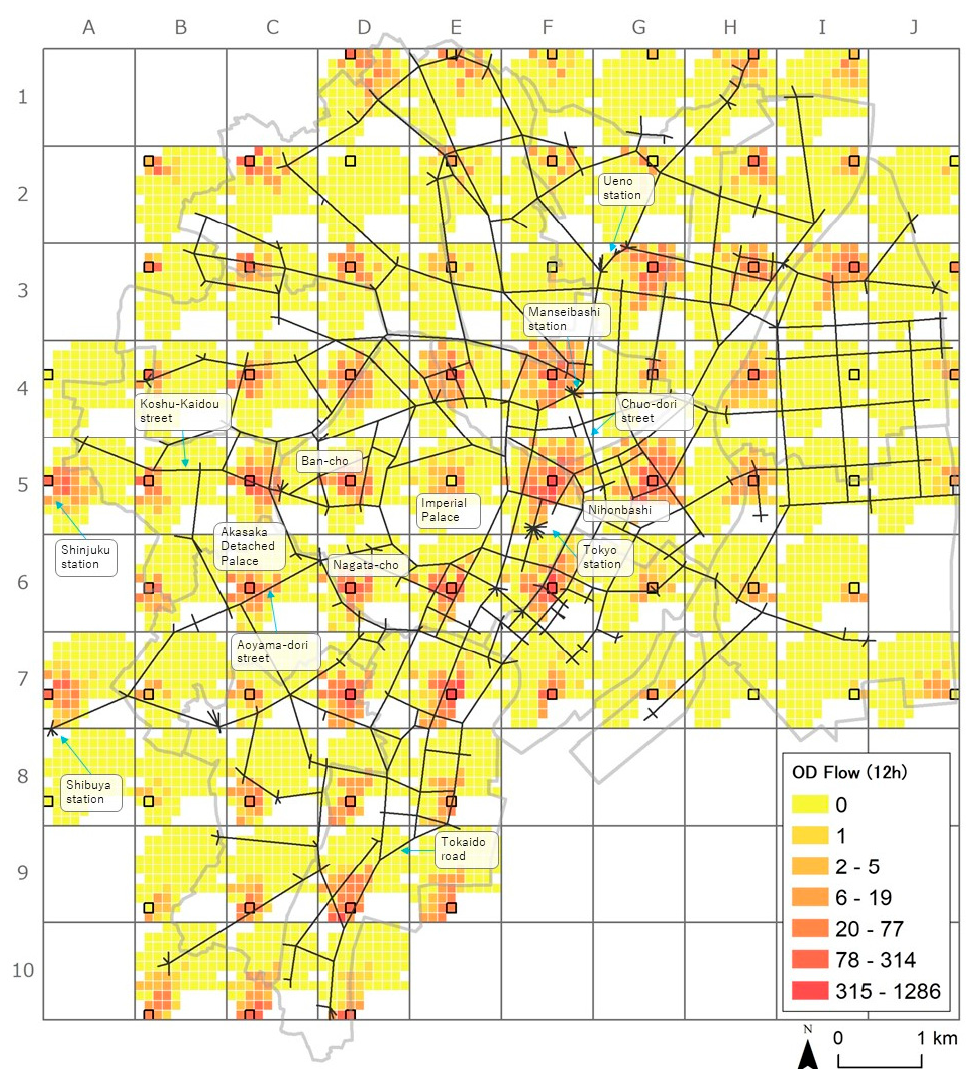
Figure 9. Estimated OD flows.